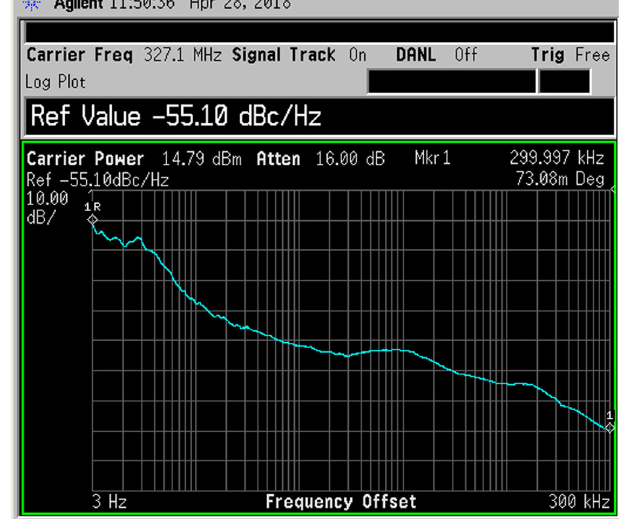
FIG. 14. Measured phase noise of the cavity field in closed- loop mode; the integrated phase noise in the cavity single sideband is less than 0.1 (cid:2) .